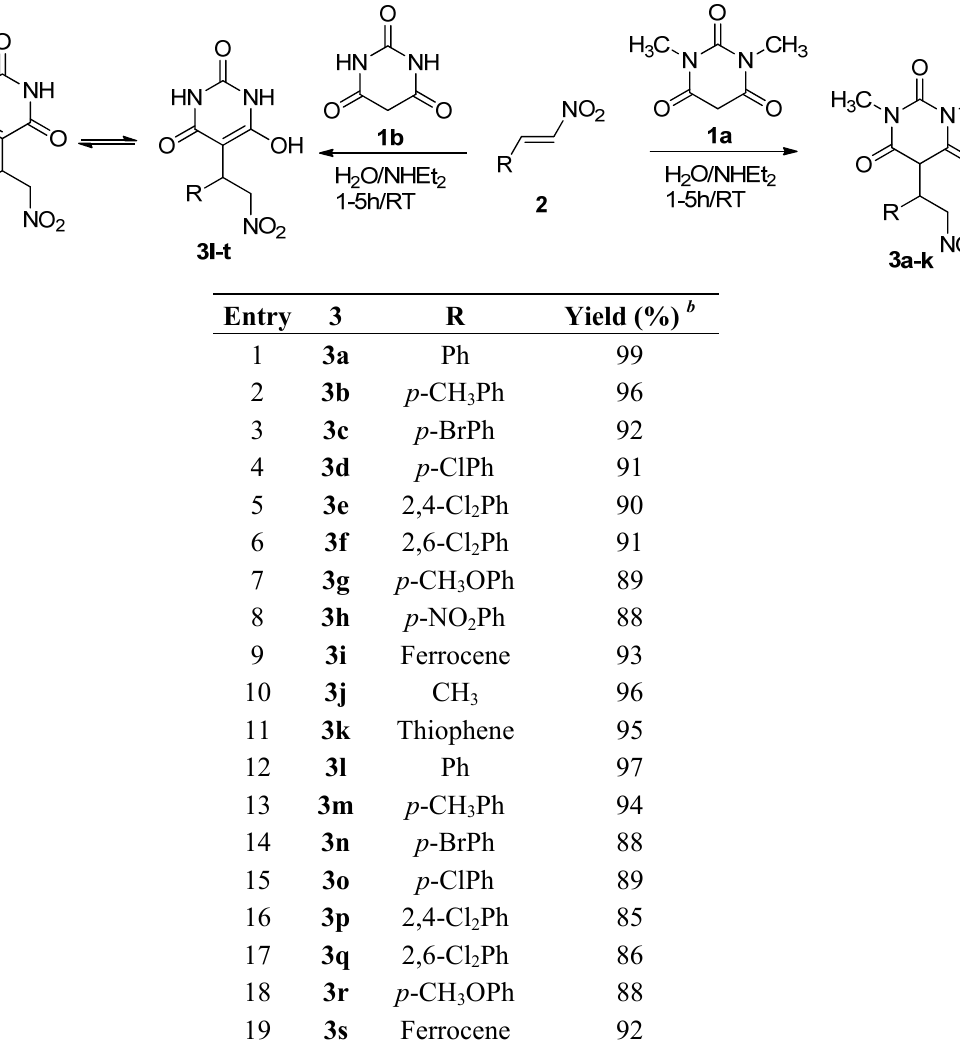
Table 2. Michael addition reaction of barbituric acid derivatives 1 to nitroolefin 2 catalyzed by Et NH in water at room temperature a 2